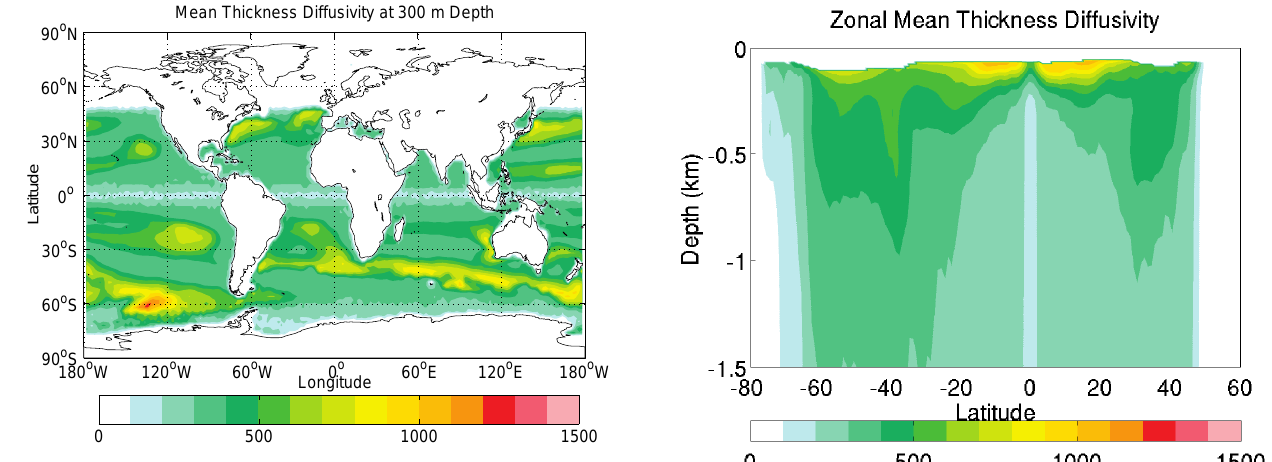
Fig. 115. Ten years mean thickness diffusivity [ m 2 s (cid:0) 1 ] at 300 m Fig. 15. The 10-year mean thickness diffusivity (m 2 s − 1 ) at 300m depth. The simulation is carried out on the reference mesh shown in depth. The simulation is carried out on the reference mesh shown in Fig. 13. Fig. 3.